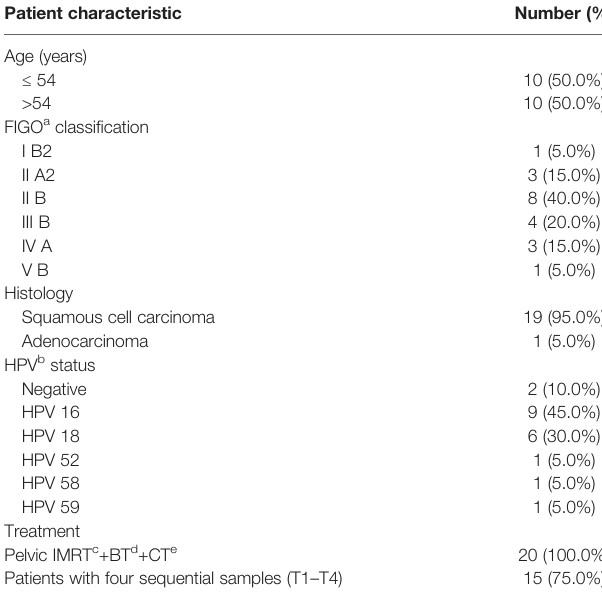
TABLE 1 | Clinical characteristics of the patients with cervical cancer ( n =